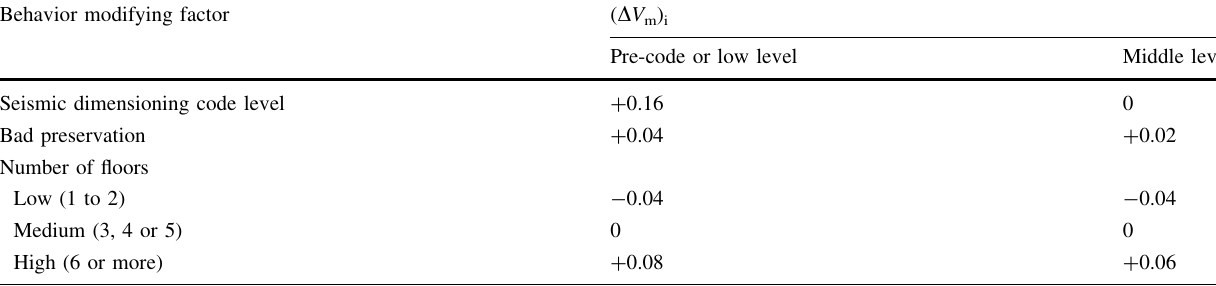
Table 4 Behavior modifying factors for buildings of reinforced concrete (RC). Source : Milutinovic and Trendafiloski (2003) Behavior modifying factor